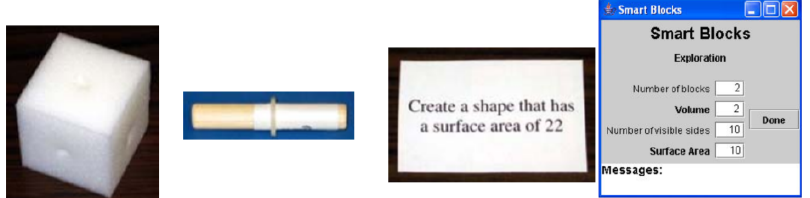
Figure 7. Proposed SmartBlocks, connector, question, a screenshot of the SmartBlocks interface (from the left) [19].